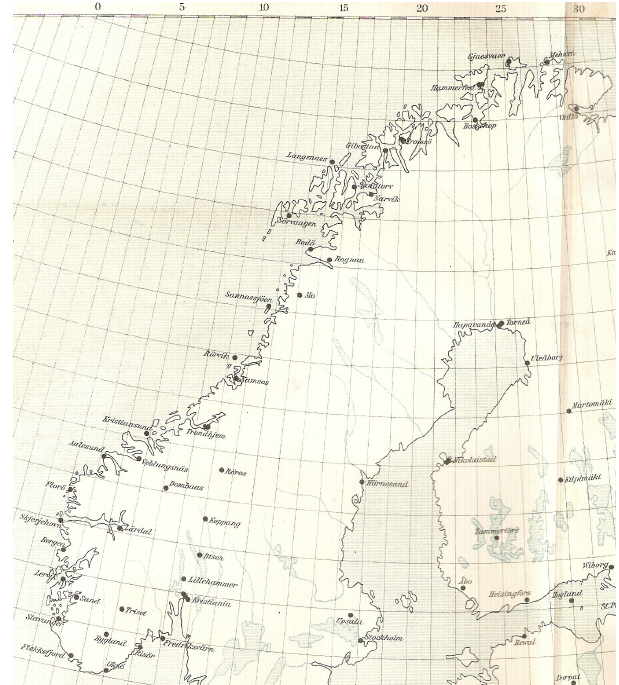
Figure 3. The first gravity network in Norway, established by pen- dulum observations by O. E. Schiøtz in 1892–1903. The locations around the Baltic Sea were measured by observers in other Nordic and Baltic countries. Table 1. Gravity at the Oslo University Observatory, as observed by Sterneck pendulums 19–22 and 33–34 (labeled Fram ). Observing